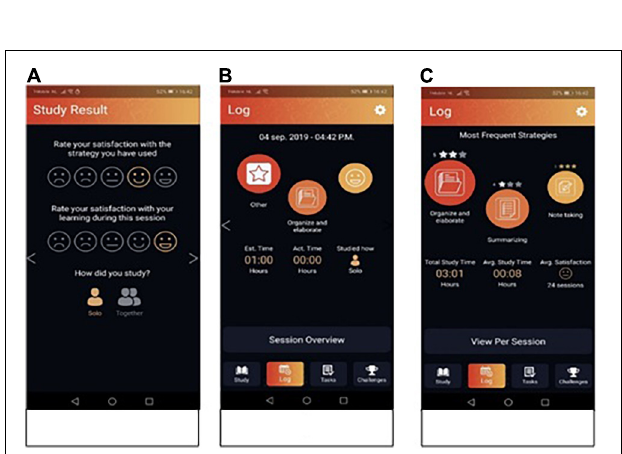
FIGURE 3 | Screenshots from the reflection phase. Panel (A) shows the two ratings students have to fill out. Panel (B) shows the log for a single session. Panel (C) shows the log across